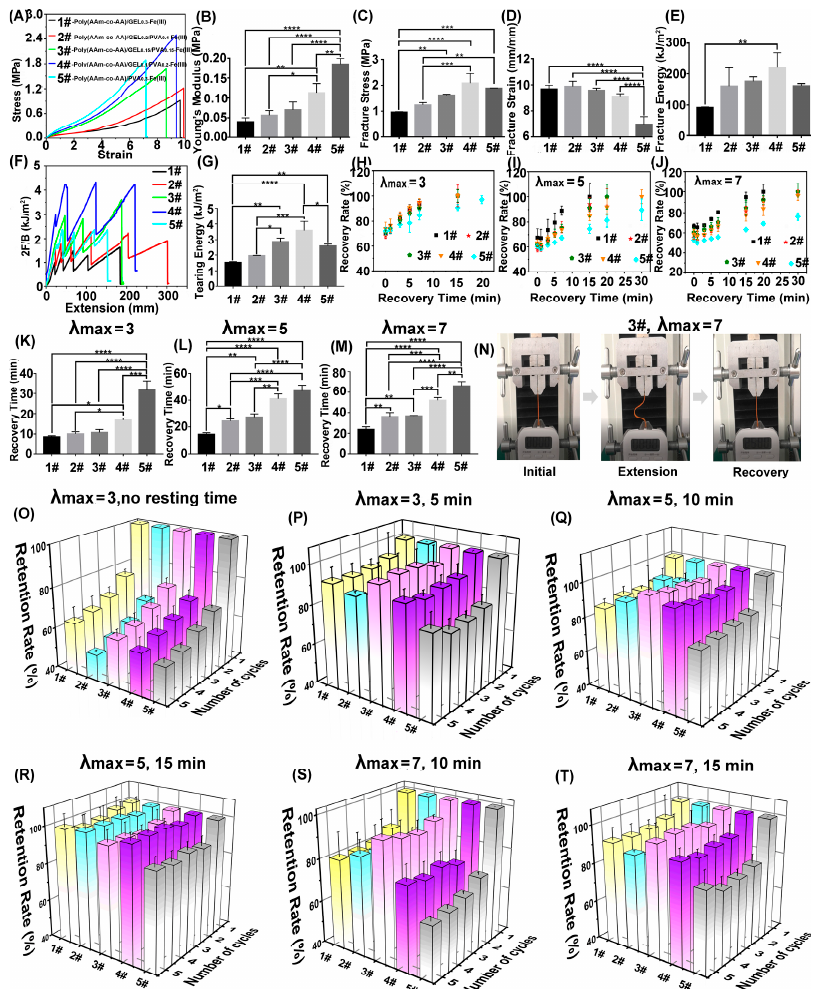
Figure 4. ( A ) Representative stress–strain curves of poly(AAm-co-AA)/GEL 0.3 -Fe(III) (1#), poly(AAm-co-AA)/GEL 0.2 /PVA 0.1 -Fe(III) (2#), poly(AAm-co-AA)/GEL 0.15 /PVA 0.15 -Fe(III) (3#), poly(AAm-co-AA)/GEL 0.1 /PVA 0.2 -Fe(III) (4#), and poly(AAm-co-AA)/PVA 0.3 -Fe(III) (5#), and histograms showing the corresponding average values of ( B ) Young’s modulus, ( C ) fracture stress, ( D ) fracture strain, and ( E ) fracture energy; Representative force-extension curves ( F ) and histograms ( G ) showing the average tearing energy of sample 1#, 2#, 3#, 4#, and 5# subjected to tearing test; Tough recovery properties of the five hydrogels extended at λ max of 3 ( H ), 5 ( I ), and 7 ( J ) and then given a resting time of 0, 1, 3, 5 7, 15, and 30 min, respectively; Shape recovery time of the five hydrogels extended at λ max of 3 ( K ), 5 (L), and 7 (M). ( N ) shows the shape recovery process of sample 3# extended at a λ max of 5; Histograms showing the toughness retention rate of the five hydrogels in five successive loading–unloading tests at different λ max and different resting time: ( O ) λ max = 3, no resting time; ( P ) λ max = 3, resting time = 5 min; ( Q ) λ max = 5, resting time = 10 min; ( R ) λ max = 5, resting time = 15 min; ( S ) λ max = 7, resting time = 10 min; and ( T ) λ max = 7, resting time = 15 min. * p < 0.05, ** p < 0.01, *** p < 0.005, and **** p <